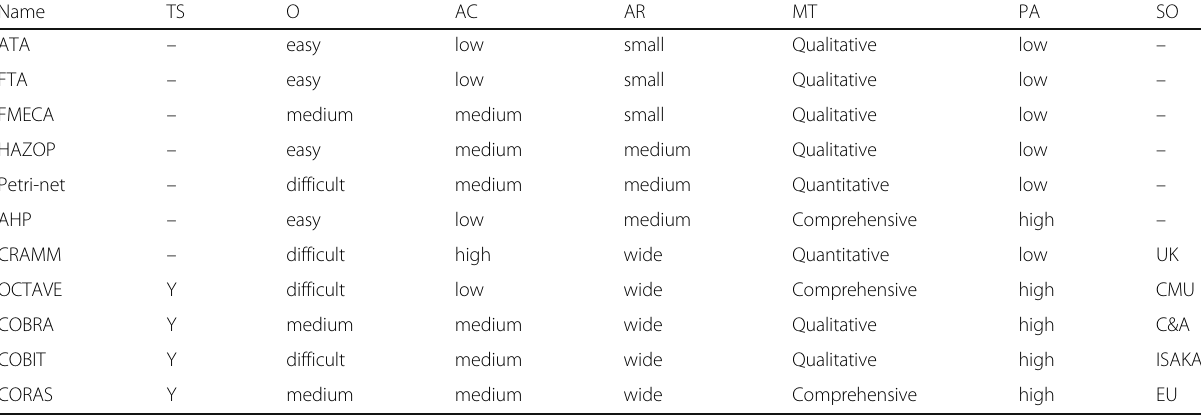
Table 1 Assessment to the security risk assessment